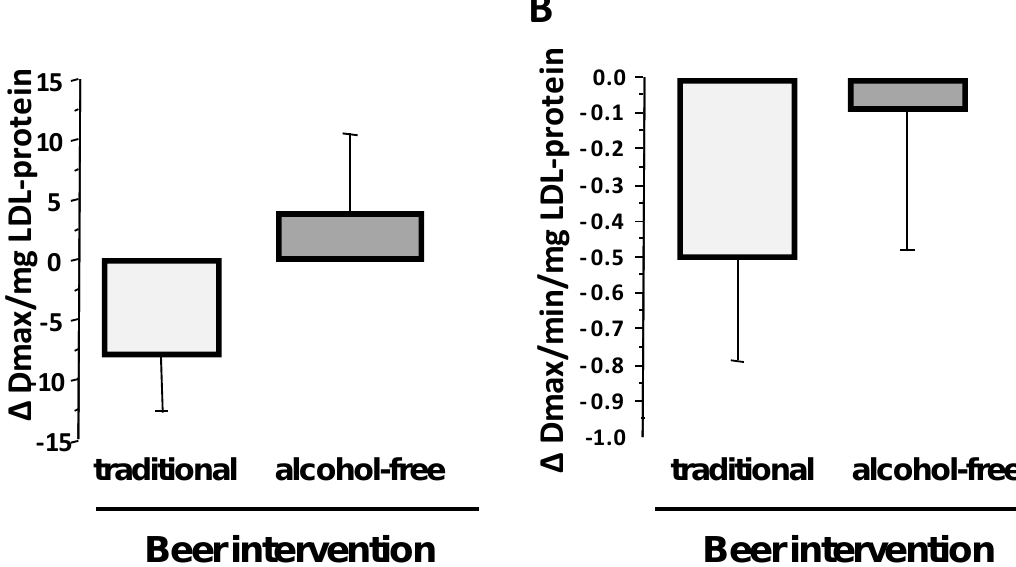
Figure 2. Effect of four-week intervention with alcohol-free and traditional beer on the susceptibility of plasma LDL to be oxidized. Values are given as change verses baseline for ( A ) maximal value for generated conjugate dienes, and ( B ) Vmax that conjugate dienes are generated. Bars refer to mean values and lines to standard error of the mean (SEM).